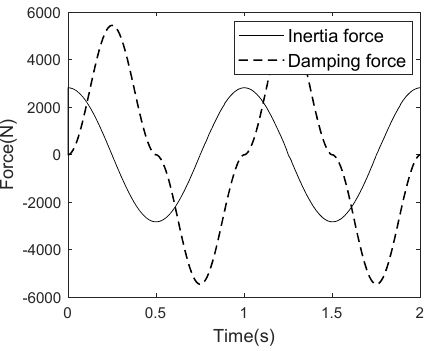
The inertial and damping forces are shown in Figure 2.